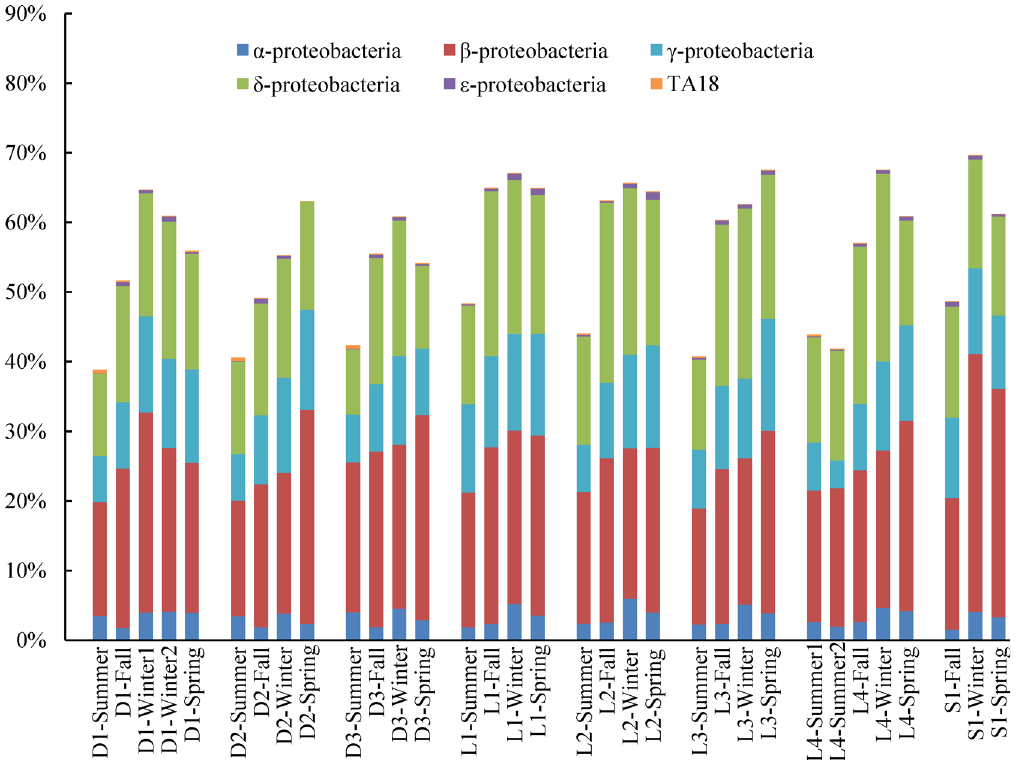
Fig 2. The seasonal variation of abundances of Proteobacteria . The abundance is presented in terms of percentage in total effective bacterial sequences in each sample.